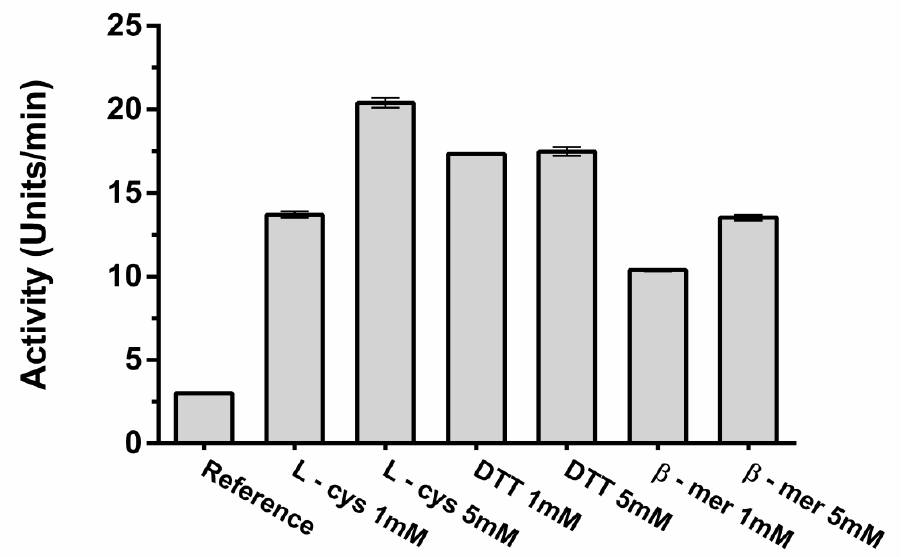
Figure 7. Effect of reducing agents on the azocaseinolytic activity of fraction F1.0. ( L -cys) L -cysteine; (DTT) Dithiothreitol; ( β -mer) β -mercaptoethanol. The values represent mean ± SEM ( n =